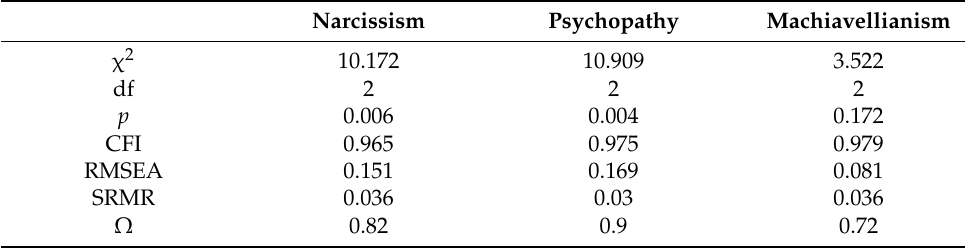
Table 2. Model fits for all measurement models.